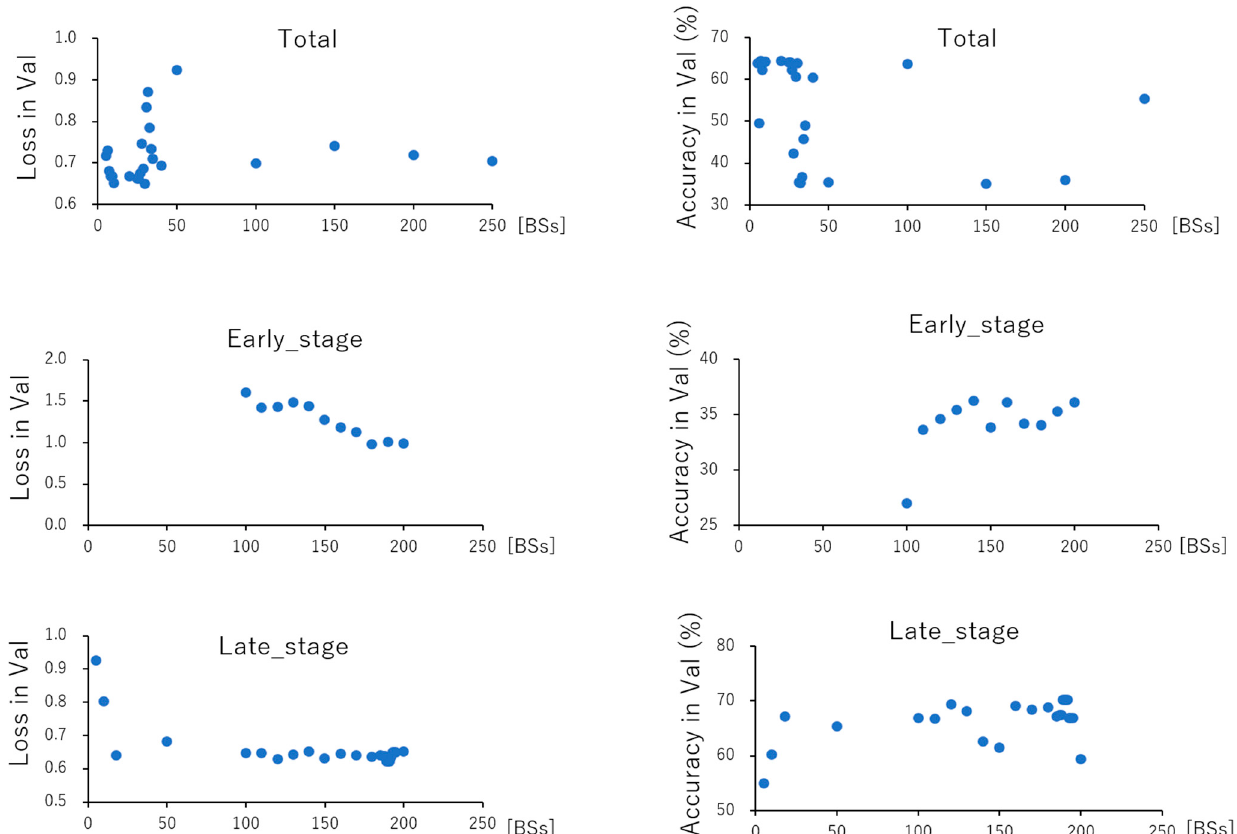
Figure 2. Performance measures of the DL prediction models as functions of the BS. Plotted are the loss values ( left ) and accuracies ( right ) with the Val datasets over the total period (upper), Days 1 and 2 (middle), and Days 3 and 4 (bottom) of continuous cell culture. Table 3. best loss(Val) and best Acc(Val) in total, early_stage, and late_stage datasets with BS. Table 2. Mean loss(Val) and mean Acc(Val) in total, early_stage, and late_stage datasets with